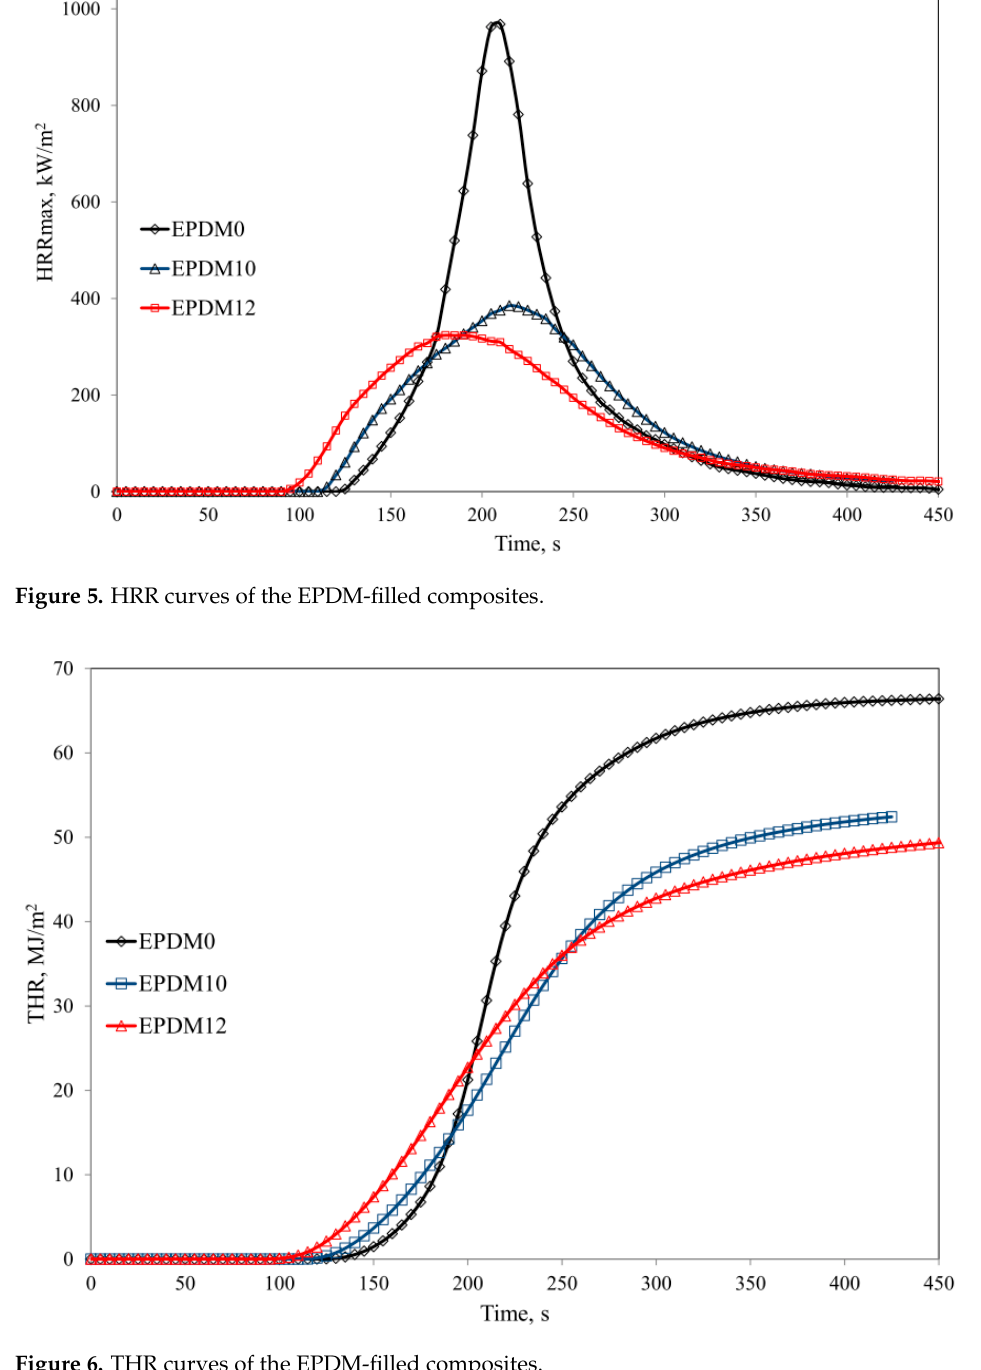
Figure 6. THR curves of the EPDM-filled composites.